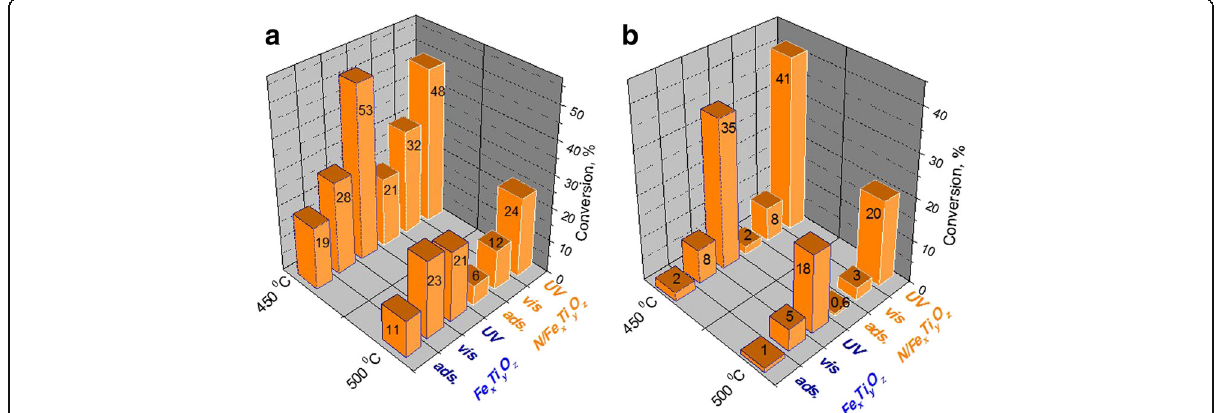
Fig. 1 Adsorption level and photocatalytic activity of iron titanate films calcined at different temperatures in the processes of TC degradation ( a ) and dichromate reduction ( b )